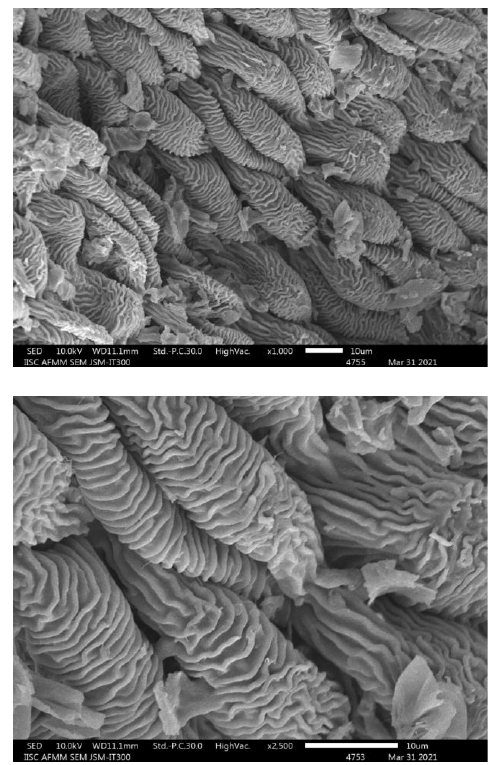
Figure 4. SEM images of YCP observed at 1000x (top) and 2500x (bottom)